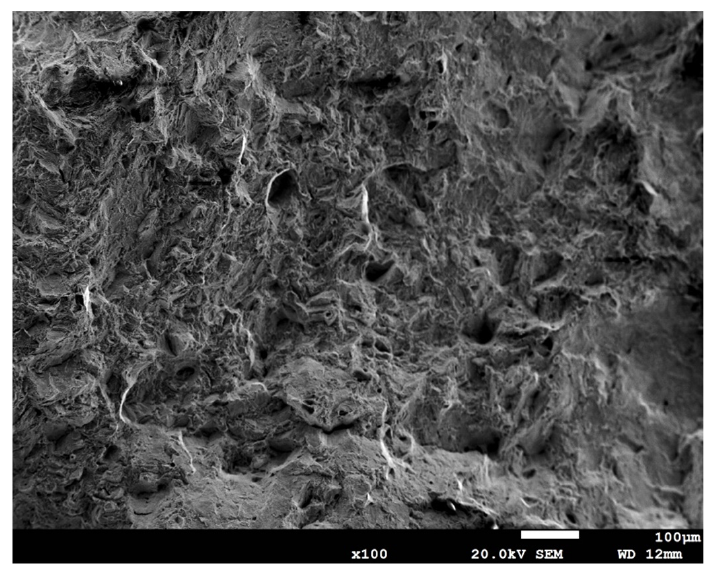
Figure 13. Fracture surface of optimal specimen.